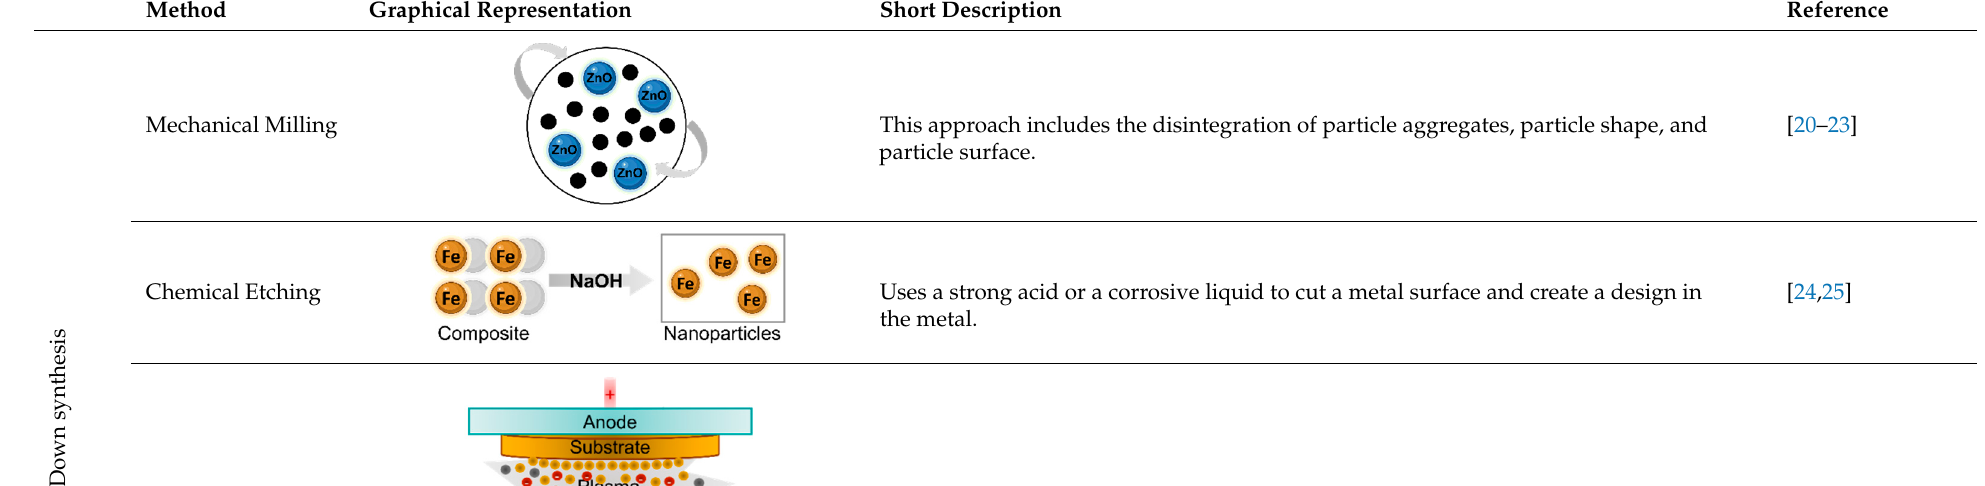
Table 1. Different methods for M-NPs synthesis.